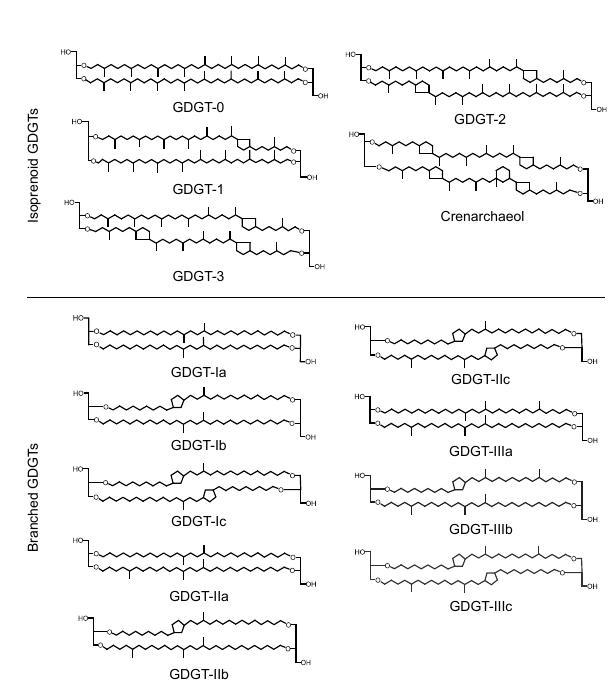
Figure A1. Chemical structures of branched GDGTs (brGDGTs) and isoprenoid GDGTs (iGDGTs) investigated in this